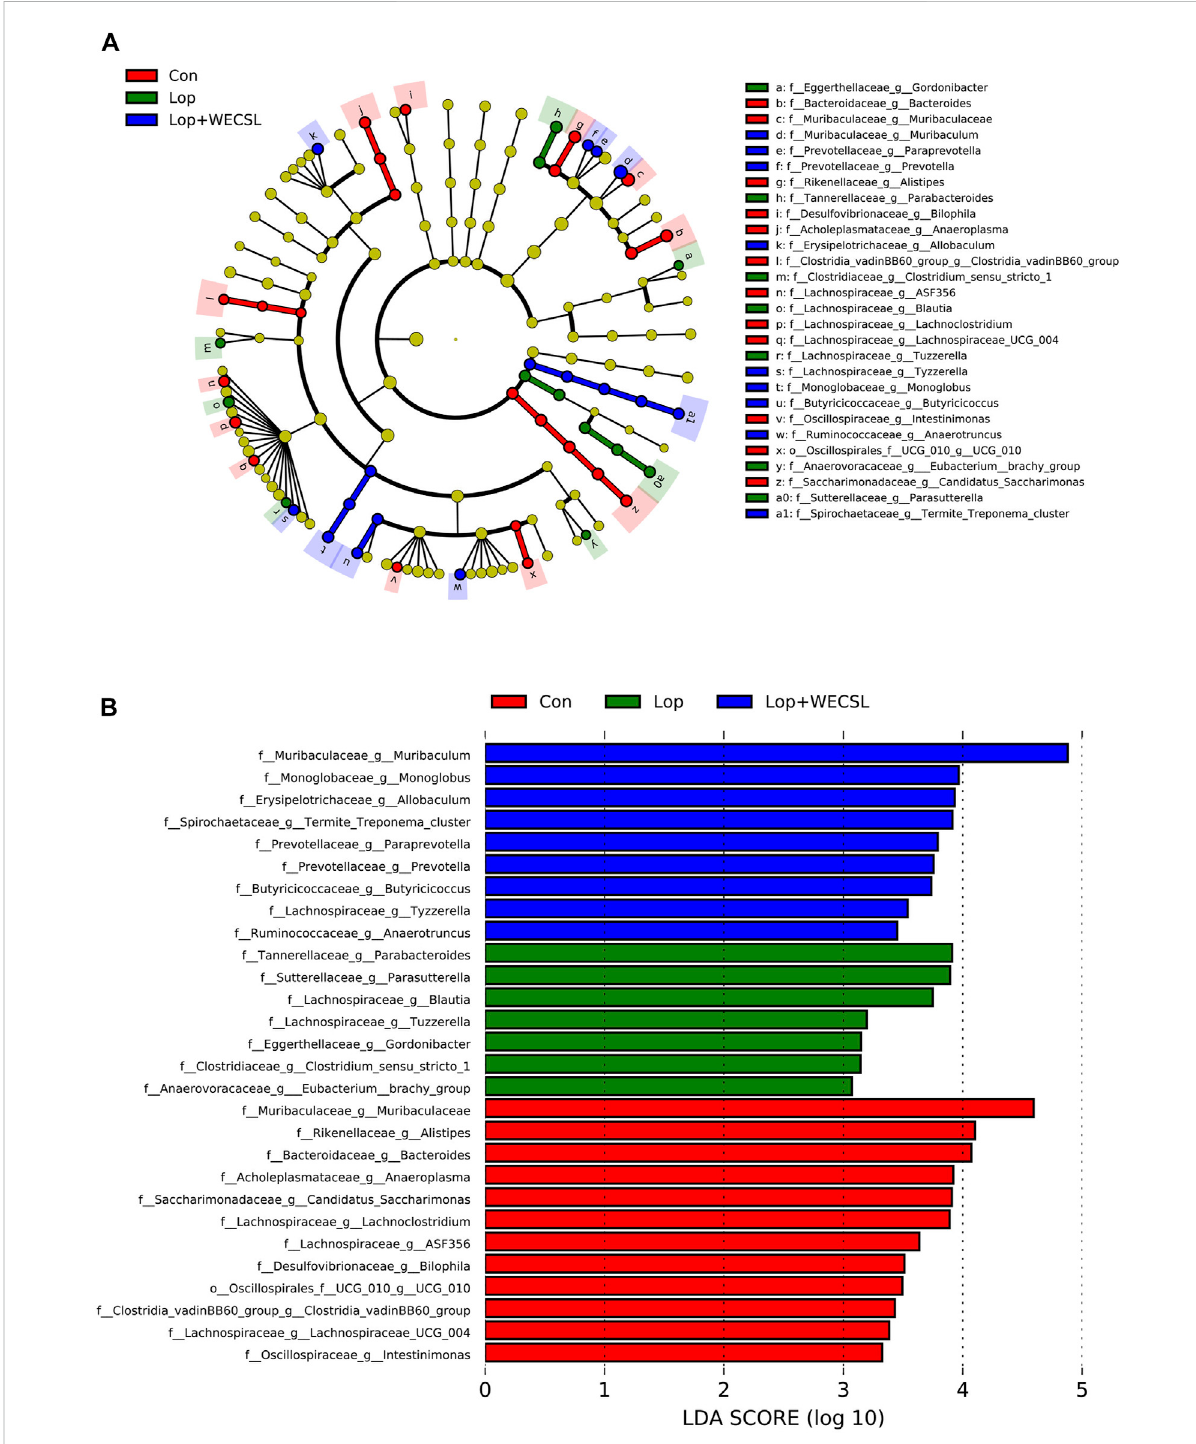
FIGURE 6 Identi fi cation of most characteristic taxa among experimental groups by linear discriminant analysis (LDA) effect size (LEfSe). (A) Taxonomic abundance analysis on differentially enriched taxa among three groups using LEfSe. The circle size is proportional to the relative abundance of each taxon. (B) Most signi fi cantly differences ofintestinalbacteria taxa amongthree groups after LDA usingathresholdscore largerthan 3.The barlength represents the LDA score, and color represents the enrichment direction in different